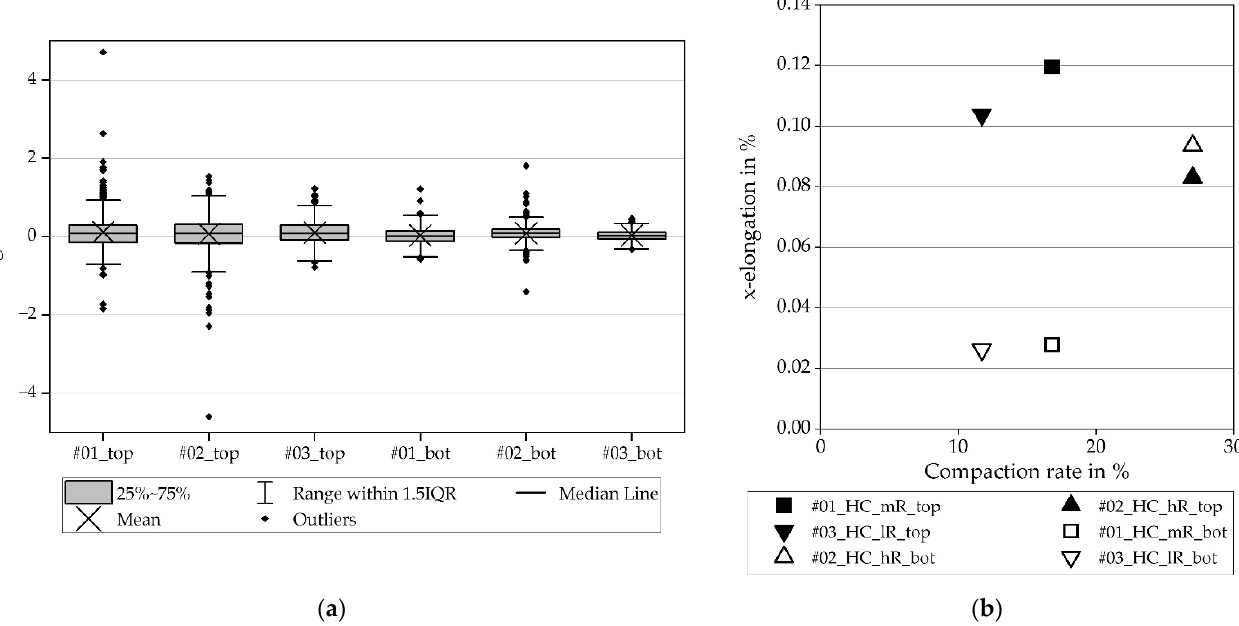
( b ) Figure 13 . Elongation in y-direction for the hard carbon anode, coating (_top) and current collector foil (_bot): ( a ) elonga- tion with scatter ( b ) average values .